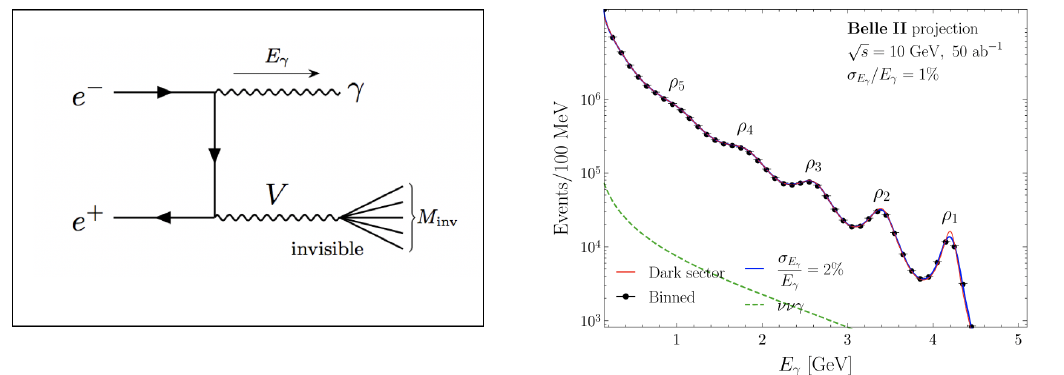
Figure 8: Reproduced from [ 20 ] . Left: Mono-photon production at a lepton collider. Right: The cross section for e + e − → γ + inv at gauge theory with 4 Weyl fermions, dark photon mass m m π = 1 GeV, lightest dark ρ meson m ρ = 0.1, with 1% energy resolution. The SM background e + e − → γνν is coupling α D shown in